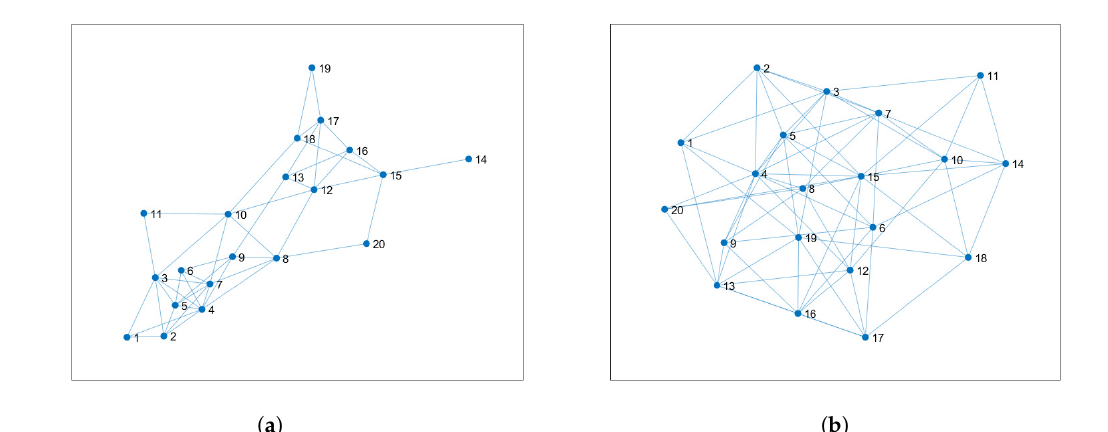
Figure 7. ( a ) Sensor network with density d 2 = 0.48. ( b ) Sensor network with density d 3 =